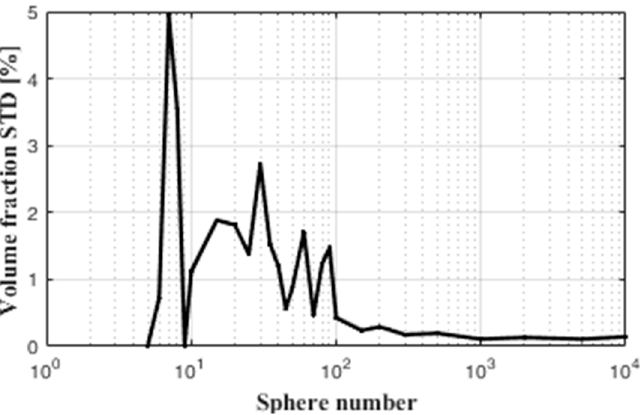
Figure 4. Volume fraction obtained as a function of the number of particles.